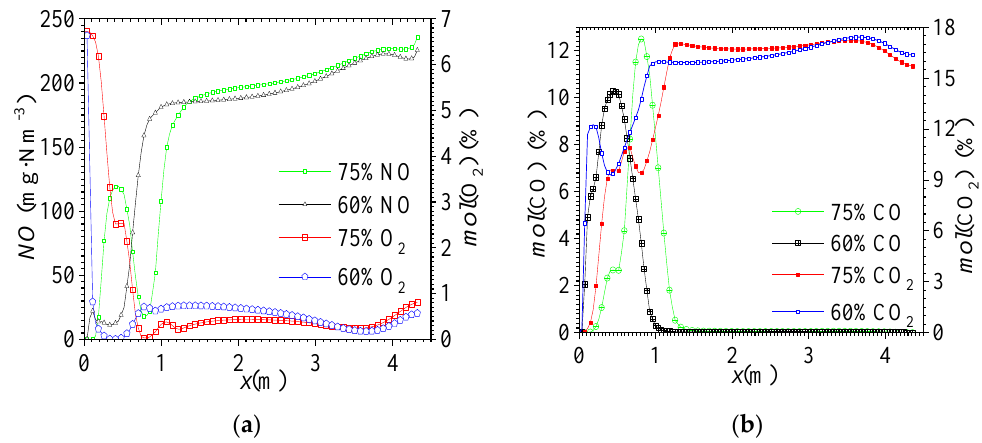
Figure 6. Species variation along the center axis of burner. ( a ) NO concentration and O 2 molar fractions; ( b ) CO and CO 2 molar fractions.